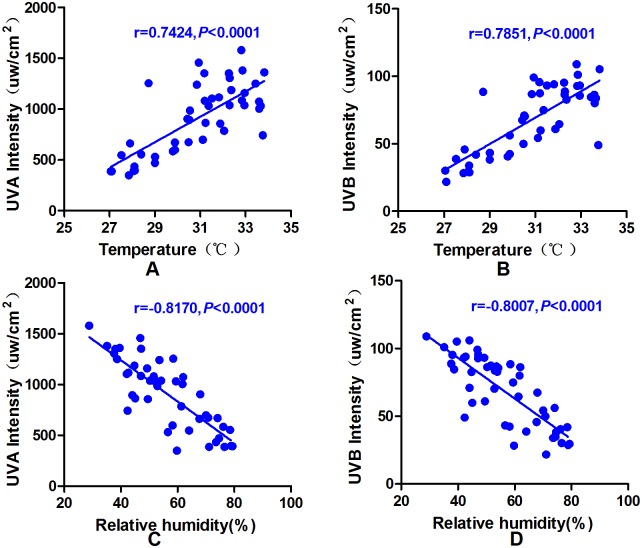
The relationship between ultraviolet intensity and humidity and temperature.A/B: Pearson’s correlation analysis revealed a significant positive correlation between temperature and UVA/UVB intensity (UVA: r = 0.7424, P<0.0001; UVB: r = 0.7851, P<0.0001). C/D: Pearson’s correlation analysis showed a significant negative correlation between relative humidity and UVA/UVB intensity (UVA: r = -0.8170, P<0.0001; UVB: r = -0.8007, P<0.0001).